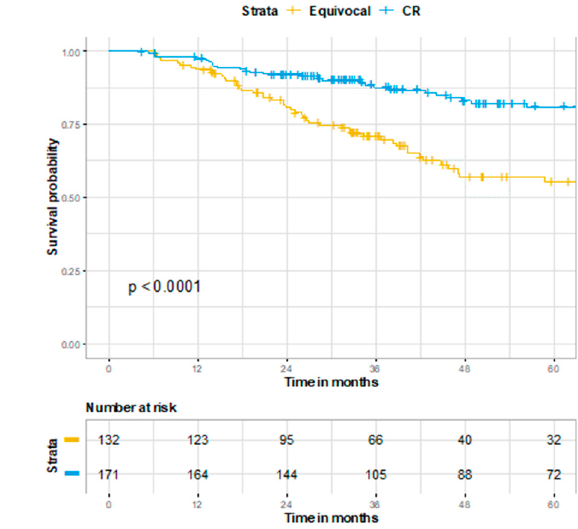
( A ) Freedom from progression ( B ) Disease-specific survival Figure 3.